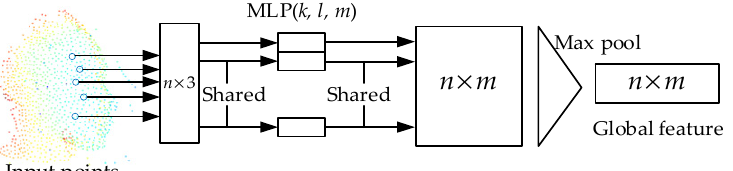
Figure 3. The structure of Pointnet. Each point is mapped into the feature space by three convolu- tional layers, and a max pooling layer acts as the symmetric function to extract the global feature of the point cloud.